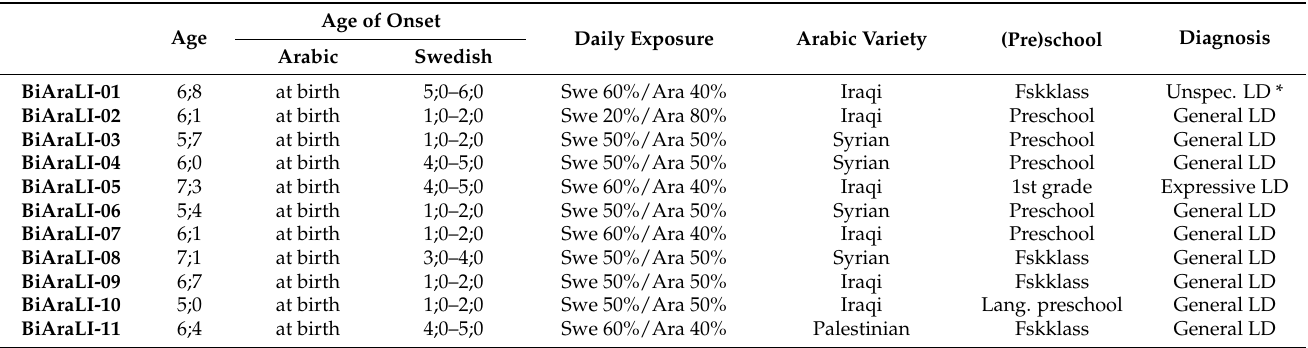
Table 2. Age at testing, age of onset for Arabic and Swedish, daily exposure, Arabic variety, (pre)school type, and diagnosis for the children in the DLD